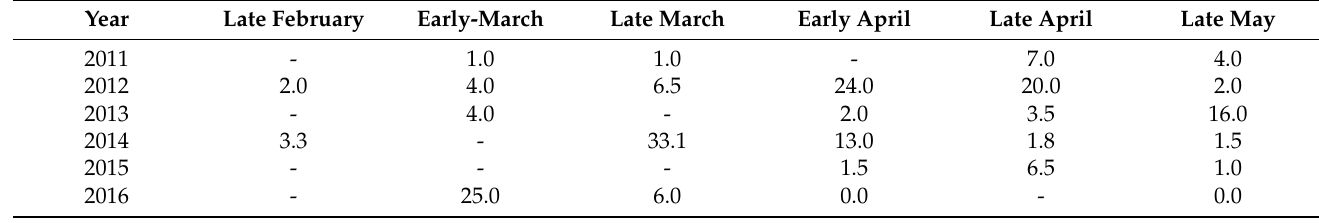
Table 2. Total abundance (individuals m –2 ) of red king crab larvae in the plankton in Ura Bay in 2011–2016 (adapted from [81]).